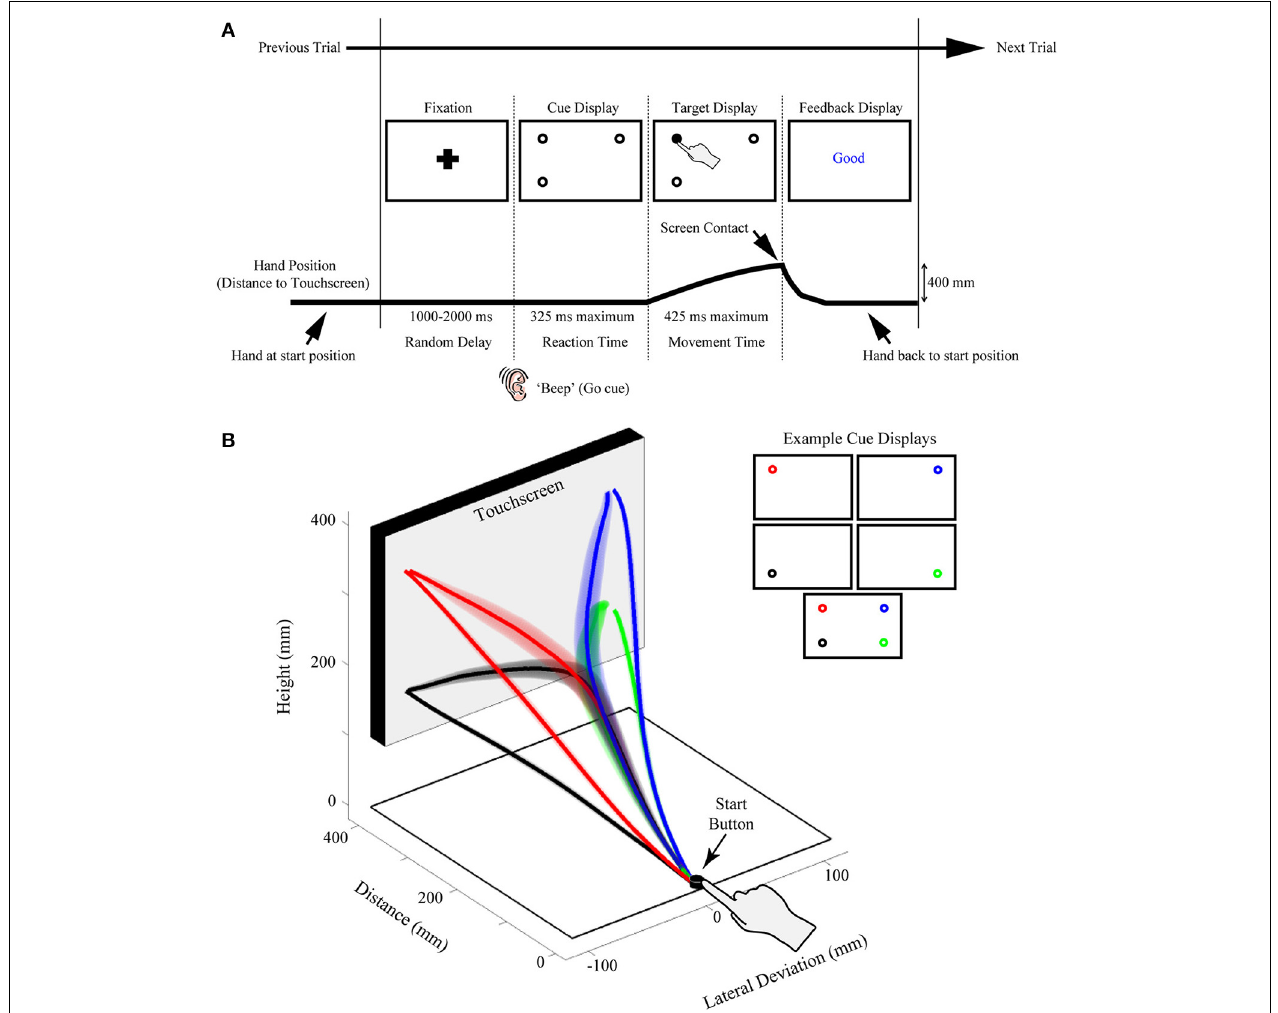
FIGURE 1 | Illustration of the rapid reach task and examples of subjects’ average arm trajectories. (A) Sequence of events for a representative single trial. Following the presentation of a fixation cross for a variable delay period, potential targets (unfilled circles) were displayed in one to four possible locationsonthetouchscreen(thebottomrightpotentialtargetlocationwasnot presented on this particular trial). In the task, subjects were required to release a start button at the onset of a “beep” go cue (which was simultaneous with theonsetofthecuedisplay)andbeginreachingtowardthetargetdisplaywithin 325ms. Immediately following button release, one of the targets in the display was selected (filled-in black) and subjects were required to correct their reach trajectory and touch the screen at that location within 425ms. Importantly, all